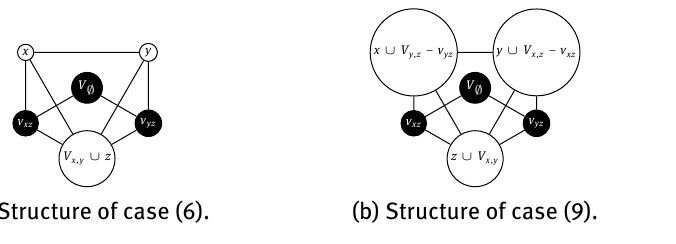
Figure 6: Graphical description of cases (6) and (9).